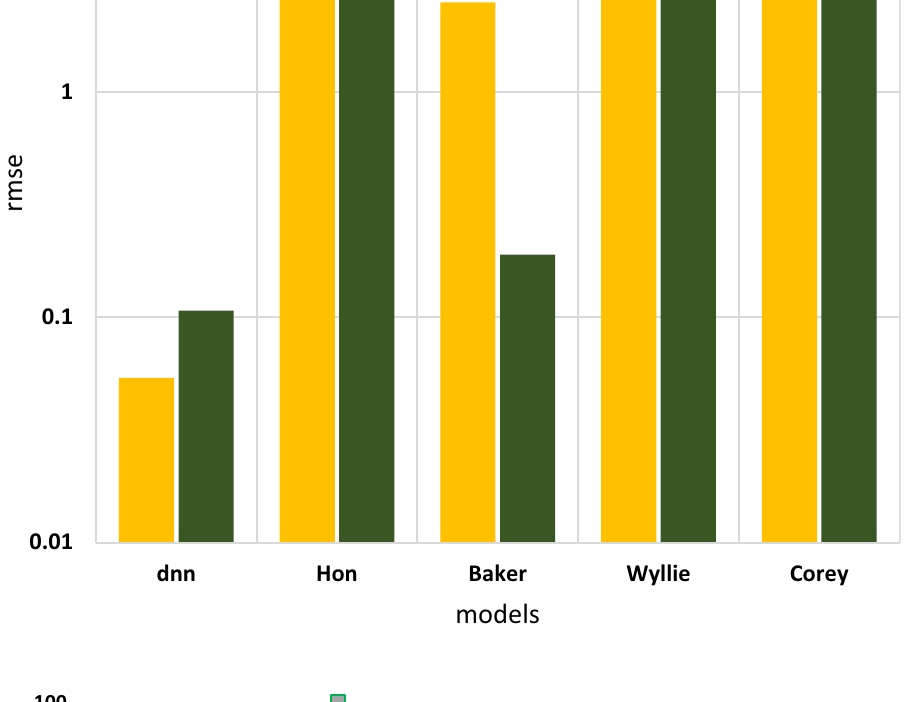
Fig. 11 Comparison of deep neural networks and Baker with the measured wetting and non- wetting relative permeability models for the validation set (Brent reservoir)